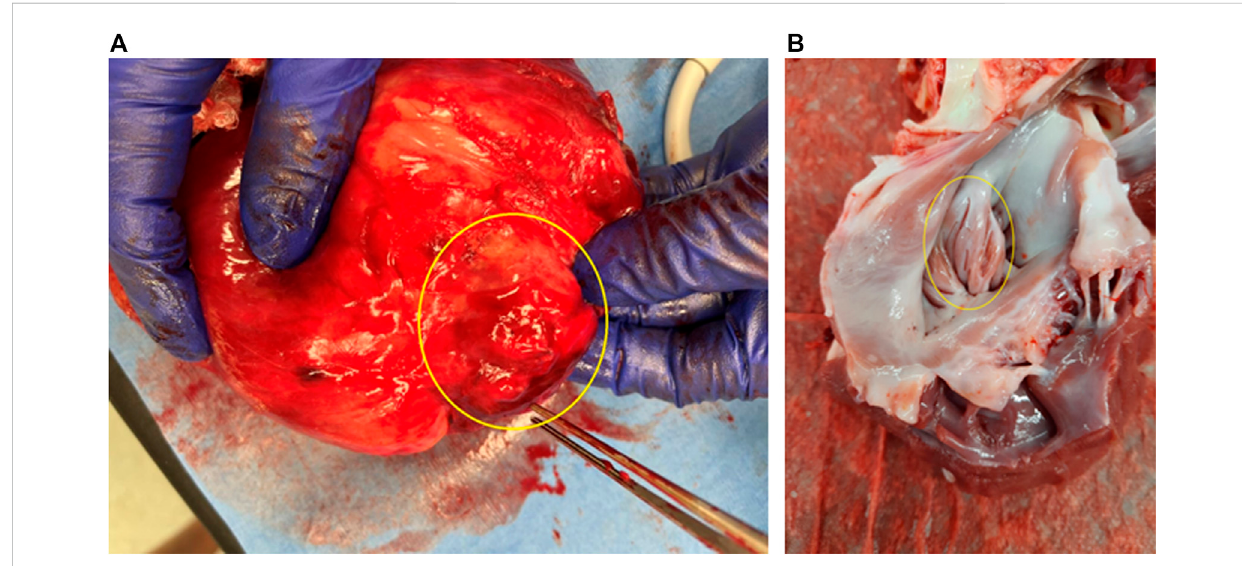
FIGURE 3 Morphology of LAA inversion(termination at8 weeks after surgery). (A) View from theoutside (epicardium). (B) View from theinside (endocardium). Yellow rings show the inverted LAA.